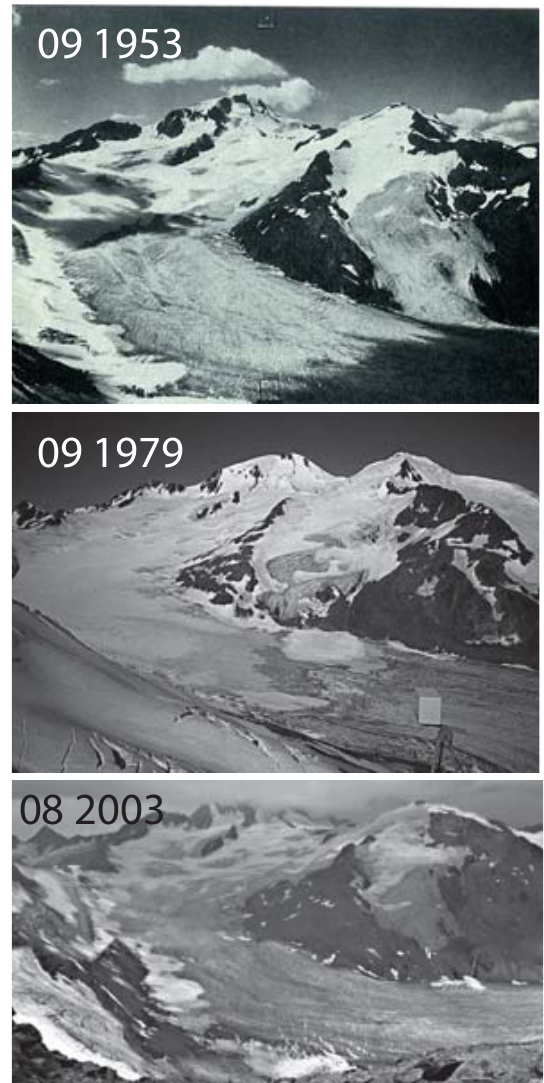
Fig. 14. Firn area of HEF in 1953, 1979 and 2003.